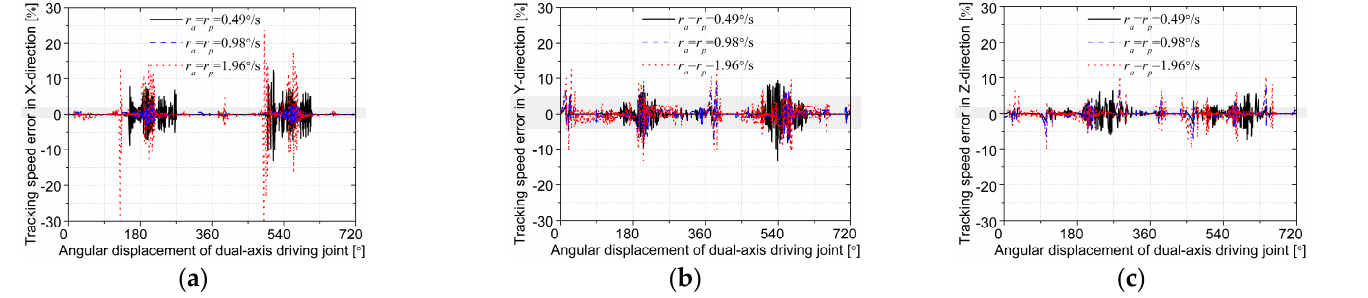
Figure 20. Tracking speed error of the antenna reflector with different rotational speeds in dual-axis driving mode: ( a ) component change in X-direction; ( b ) component change in Y-direction; and ( c ) component change in Z-direction.